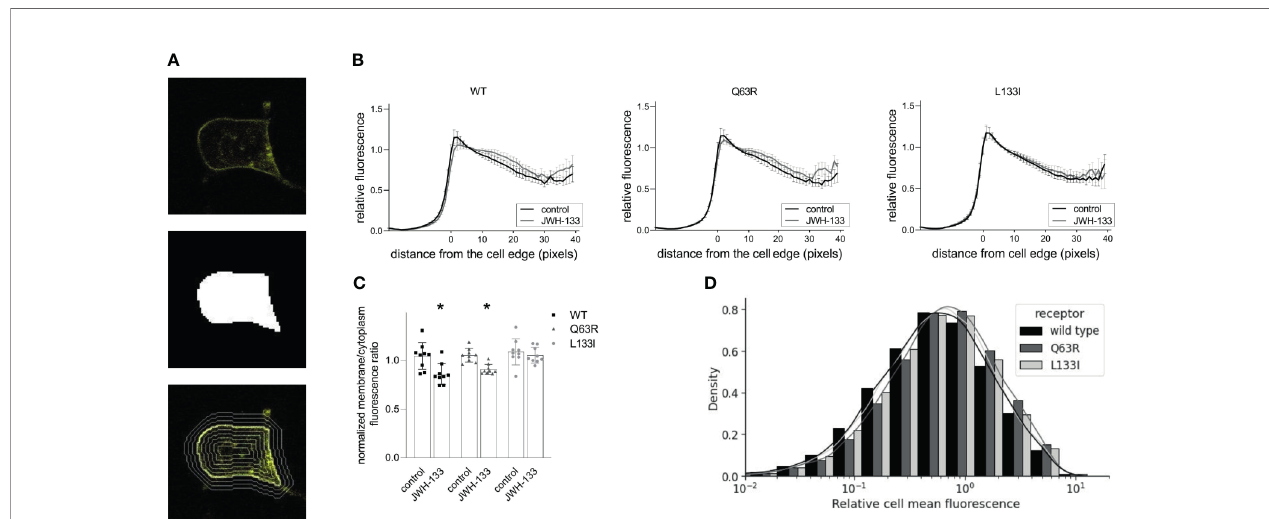
FIGURE 4 | CB2R distribution in HEK 293T cells following stimulation with JWH-133: HEK 293T cells were co-transfected with YFP-tagged CB 2 R isoforms and L10-cerulean. Confocal microscopy images were taken with Zeiss LSM 710 confocal laser-scanning microscope, and the cells were detected with cellpose, a neural network-based algorithm. For each cell, a mask covering the cell was determined ( A , top, and middle), and the mask was iteratively dilated or eroded resulting in a total of 60 contours (examples are shown on A , bottom). (B) Cell fl uorescence pro fi le was determined by measuring average fl uorescence under each contour in control and stimulated HEK293T cells. Cells expressed either CB 2 R-WT-YFP, CB 2 R-Q63R-YFP, or CB 2 R-L133I-YFP. Mean values ± S.E.M. @ are shown (n=9, ~50000 cells total). (C) Membrane (0-5 pixels from cell edge)/cytoplasm (>5 pixels from cell edge) fl uorescence ratios for the wild-type and mutant CB 2 Rs in control and stimulated cells. Mean ± S.E.M. @ are shown from n=9 experiments. * indicates a signi fi cant difference between control and stimulated samples (p<0.05), analyzed with two-way ANOVA (stimulation, mutation) using Tukey ’ s post hoc test for multiple comparisons. (D) Cell fl uorescence distribution in 9 experiments representing ~50000 cells. Fluorescence is normalized to average overall cell fl uorescence in each